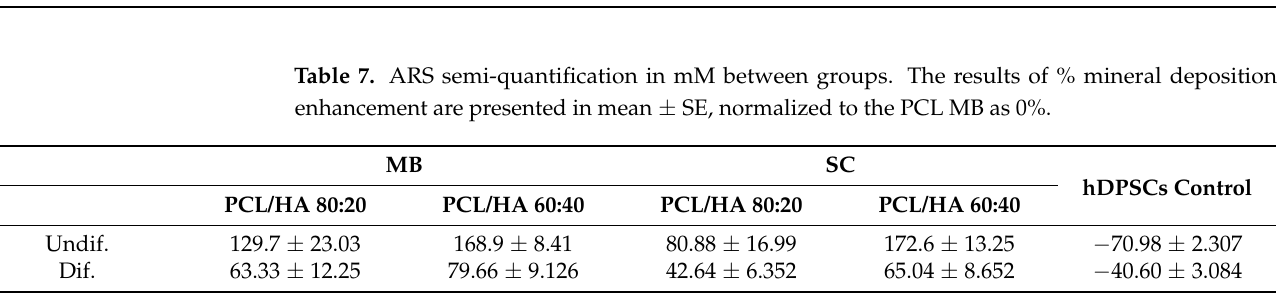
Table 6. ARS semi-quantification in mM between groups. The results are presented in mean ± SE. “Undif.” Stands for “Undiferentiated” and “Dif.” Stands for “Differentiated”. MB SC PCL MB PCL/HA 80:20 PCL/HA 60:40 PCL/HA 80:20 PCL/HA 60:40